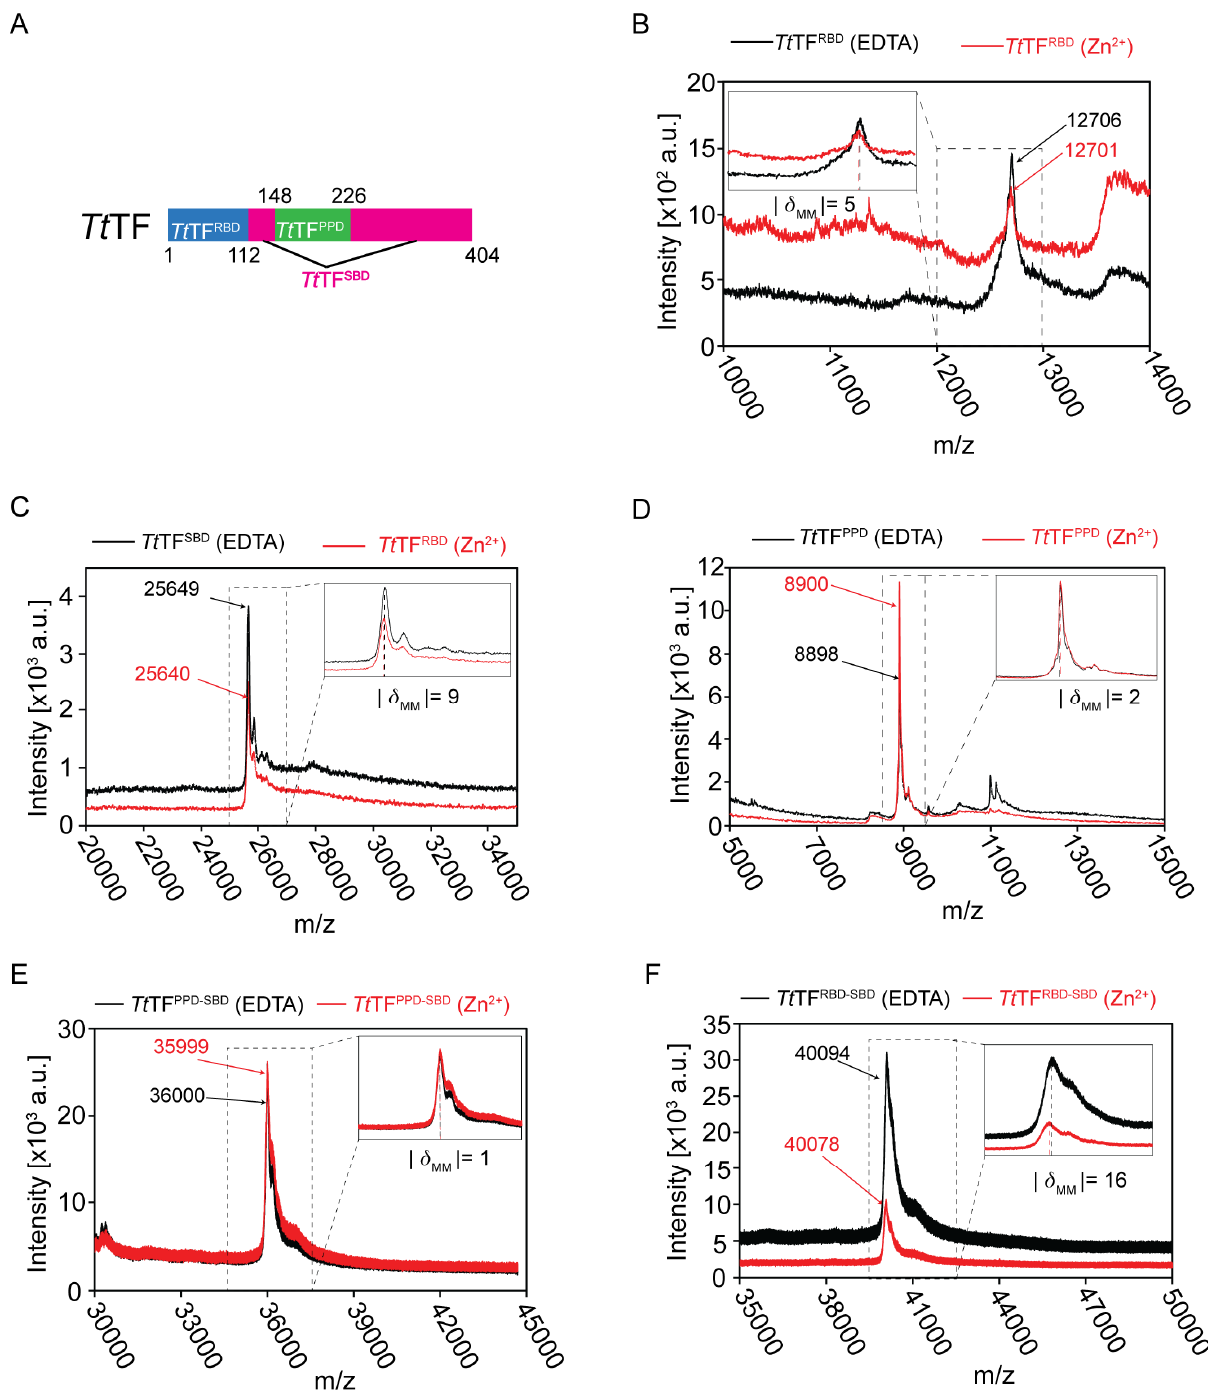
Figure 2. MALDI-TOF-MS analysis for the Tt TF domains prepared in the absence and presence of Zn 2+ . ( A ) The domain architecture of Tt TF. ( B – F ) The overlaid mass spectra for Tt TF RBD ( B ), Tt TF SBD ( C ), Tt TF PPD ( D ), Tt TF PPD-SBD ( E ), and Tt TF RBD-SBD ( F ) refolded in the presence of Zn 2+ (red) and EDTA (black). The expanded views are displayed at the top right or top left. The theoretical molar mass: 12,706 Da for Tt TF RBD (EDTA), 25,618 Da for Tt TF SBD (EDTA), 8911 Da for Tt TF PPD (EDTA), 36,193 Da for Tt TF PPD-SBD (EDTA), and 40,249 Da for Tt TF RBD-SBD (EDTA). The absolute values of the difference between the experimental molar masses (| δ MM |) of Tt TF domains (Zn 2+ ) and Tt TF domains (EDTA) are shown below the expanded views. a.u., arbitrary unit.